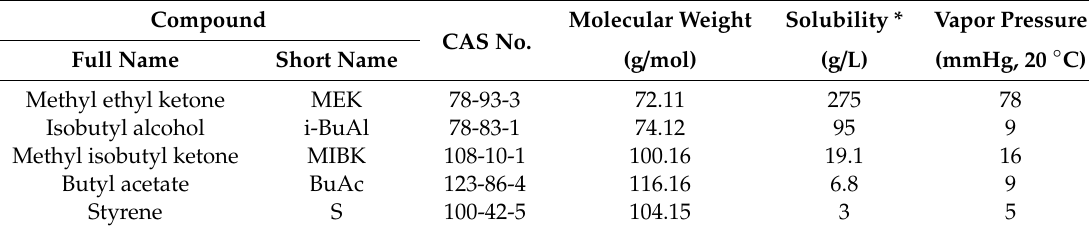
Table 1. Target odorous